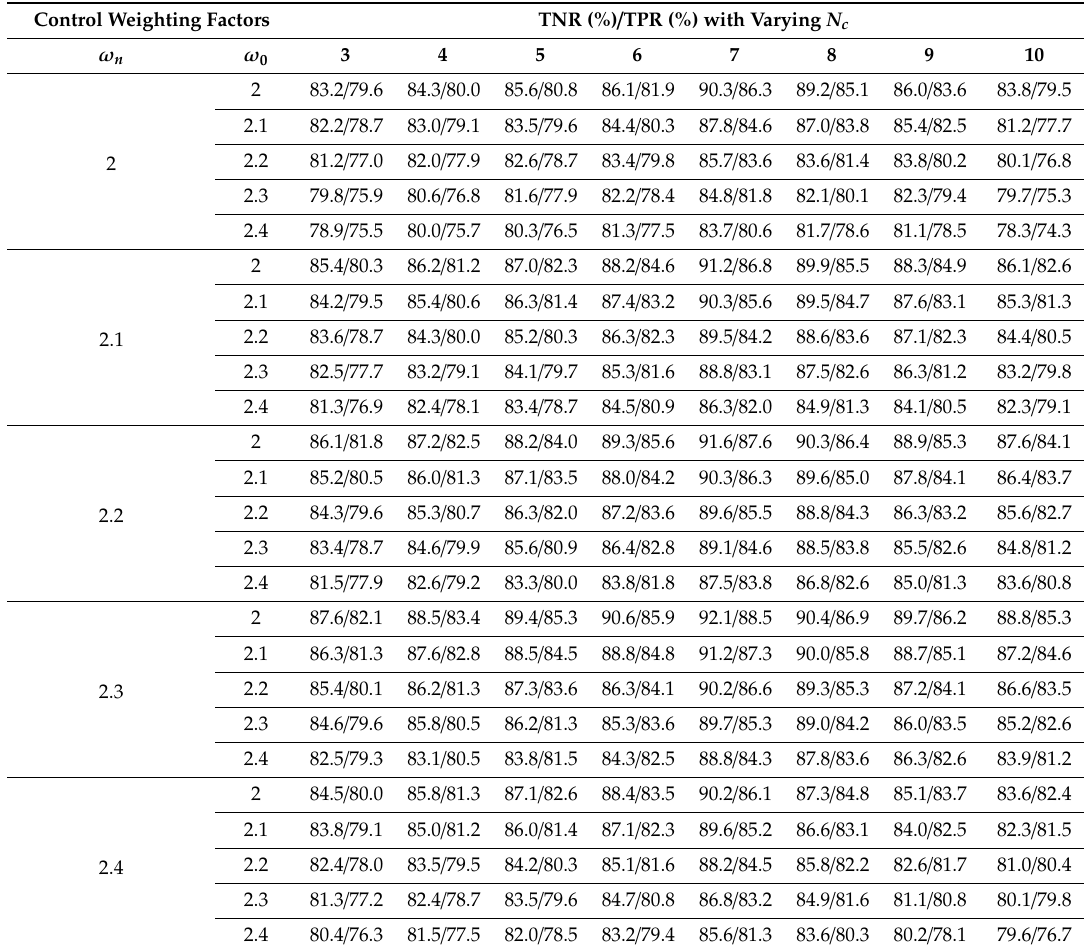
Table 4. Performance evaluation of the multi-class detection model using CGAN-IFCM while varying N c , ω n , and ω 0 with the SVD database. (a) Fixed ω n = 1.8. (b) Fixed ω n = 1.9. (c) Fixed ω n = 2.0. (d) Fixed ω n = 2.1. (e) Fixed ω n =